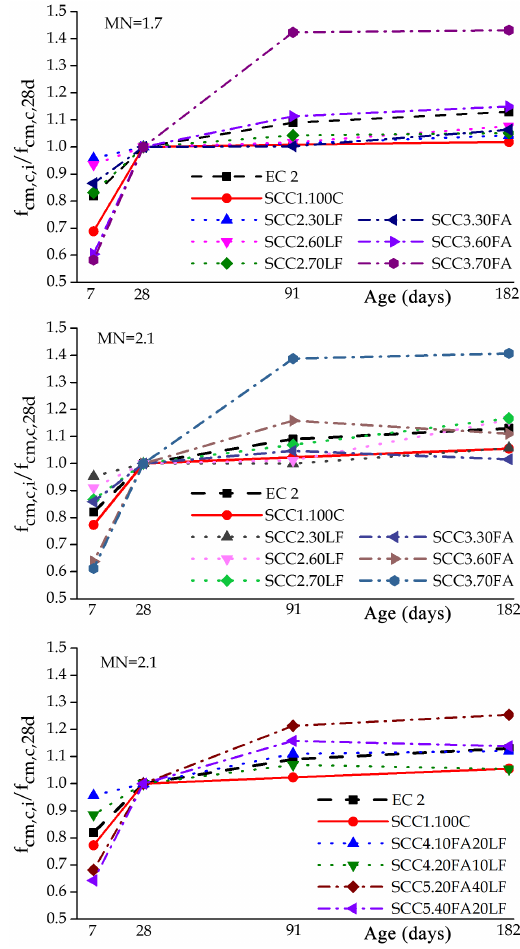
Figure 9. Correlation between f and the W/C ratio of the SCC cm,c,28d produced and the values proposed by Nepomuceno 5 . Figure 10. Concrete hardening coefficients of binary and ternary